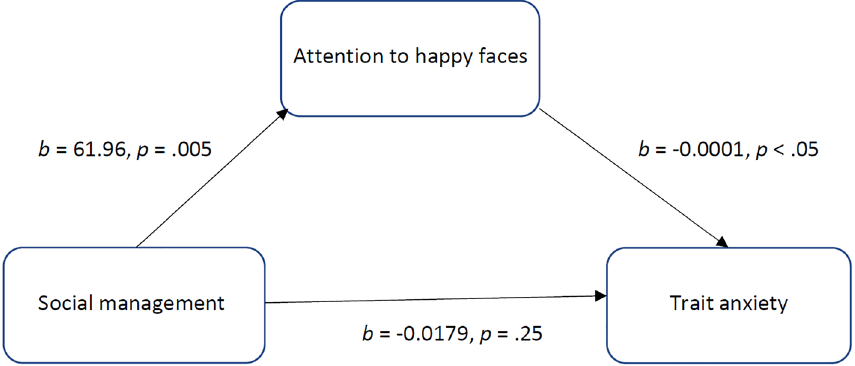
Figure 3. The mediating effect of attention to happy faces (dwell time on happy faces) in the relationship between social management and trait anxiety (STAI). All presented effects are